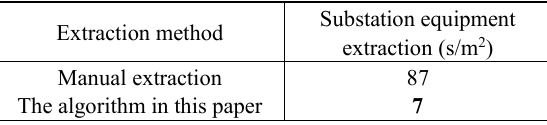
Table 2. Efficiency comparison between automatic extraction and manual